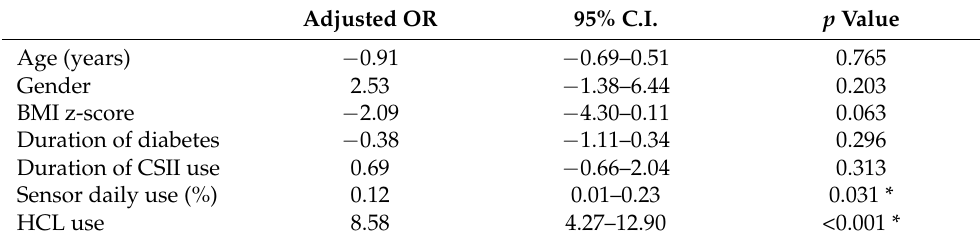
Table 2. Results of multivariate logistic regression models for %TIR.